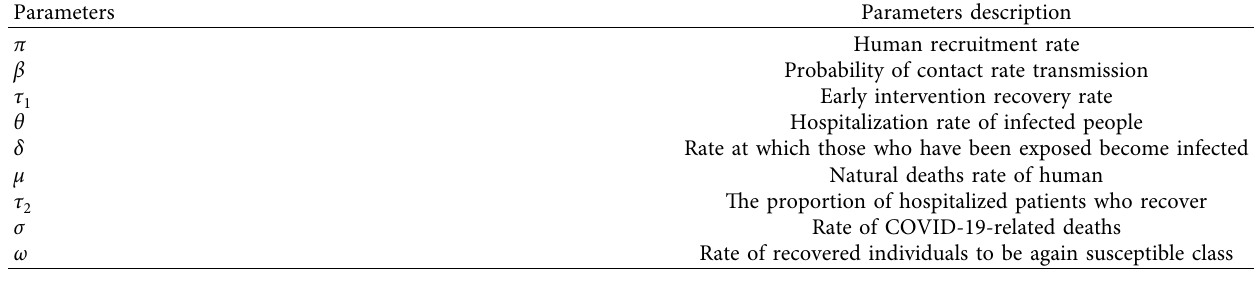
Table 1: Parameters description used for the model (1).